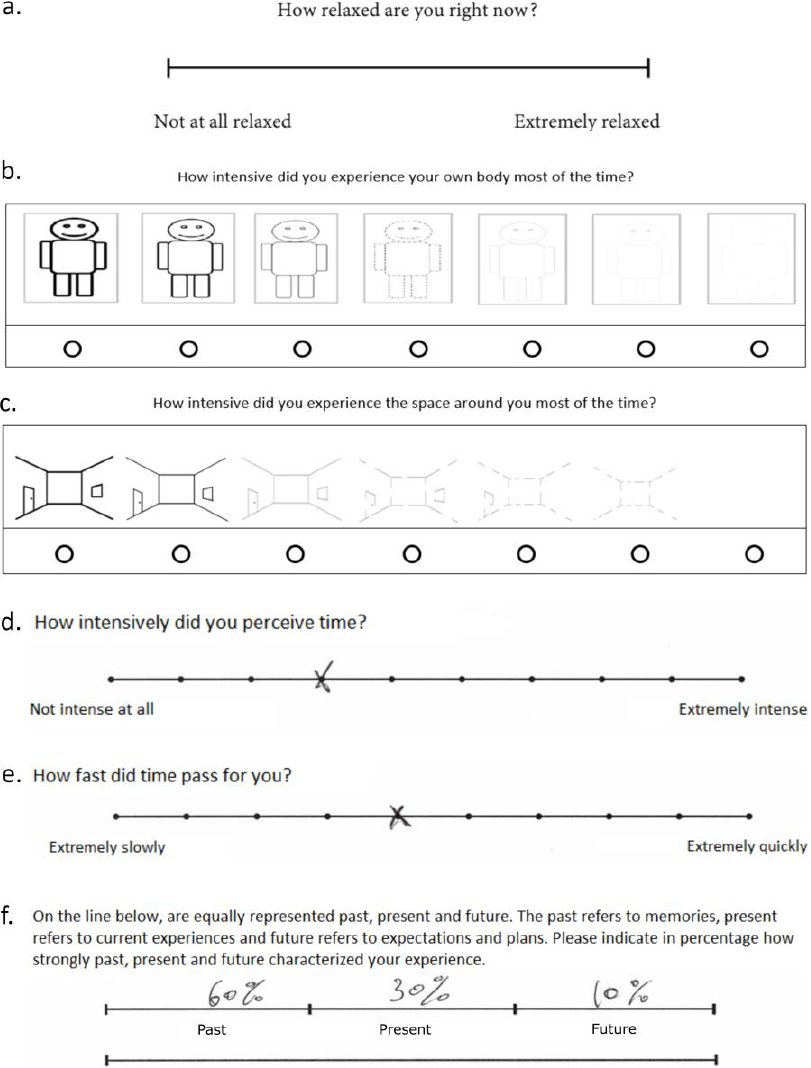
Figure 3. ( a ) VAS used to assess relaxation; ( b ) scale adopted to assess body awareness; ( c ) scale adopted to assess space awareness; ( d ) scale adopted to assess time intensity; ( e ) scale adopted to